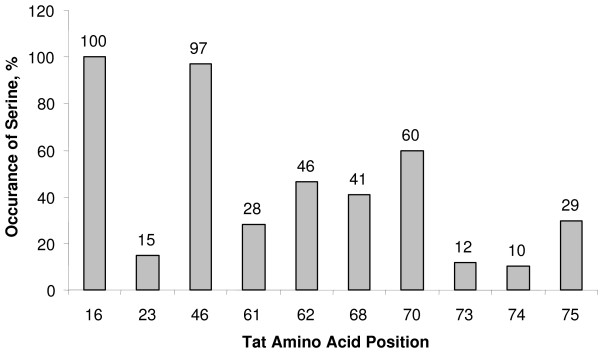
Serine residues at position 16 and 46 are highly conserved in Tat isolates. The 158 sequences of Tat isolates deposited to PubMed database were analyzed for the presence of serines at position 16, 23, 46, 61, 68, 70, 73, 74 and 75. Presence of a serine at the indicated position is presented as a percent of the total number of the isolates analyzed.